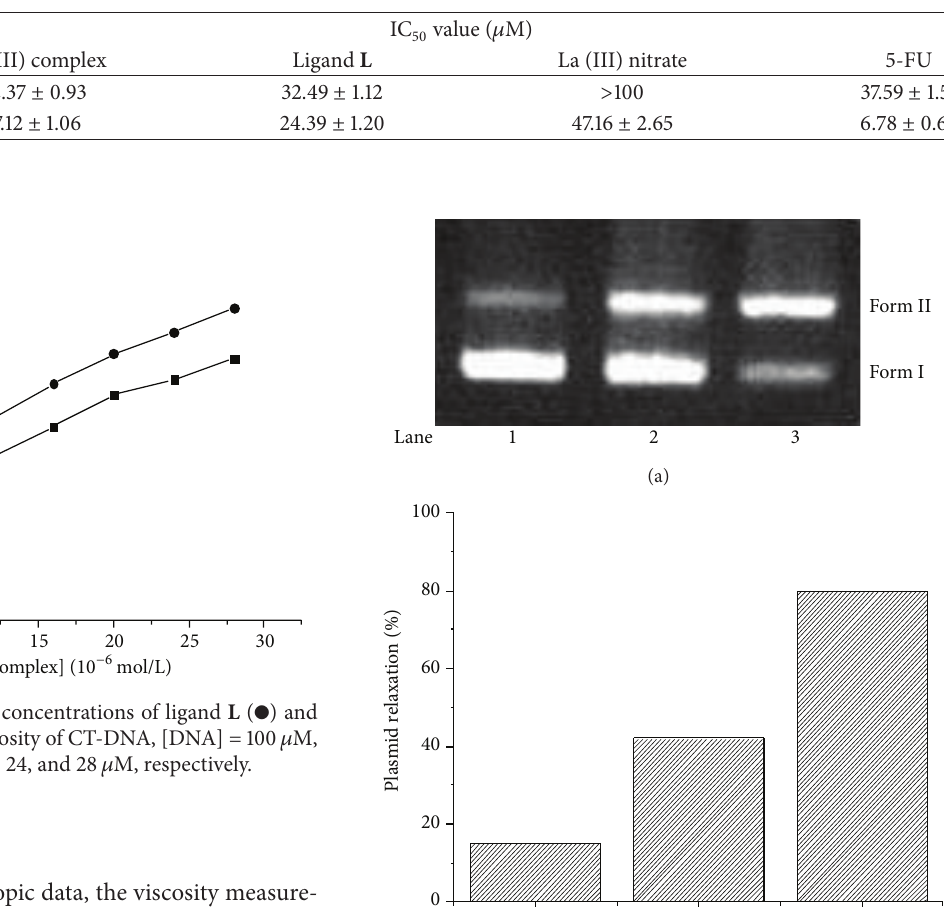
Table 4: IC values of the tested compounds against tumor cell lines. 50